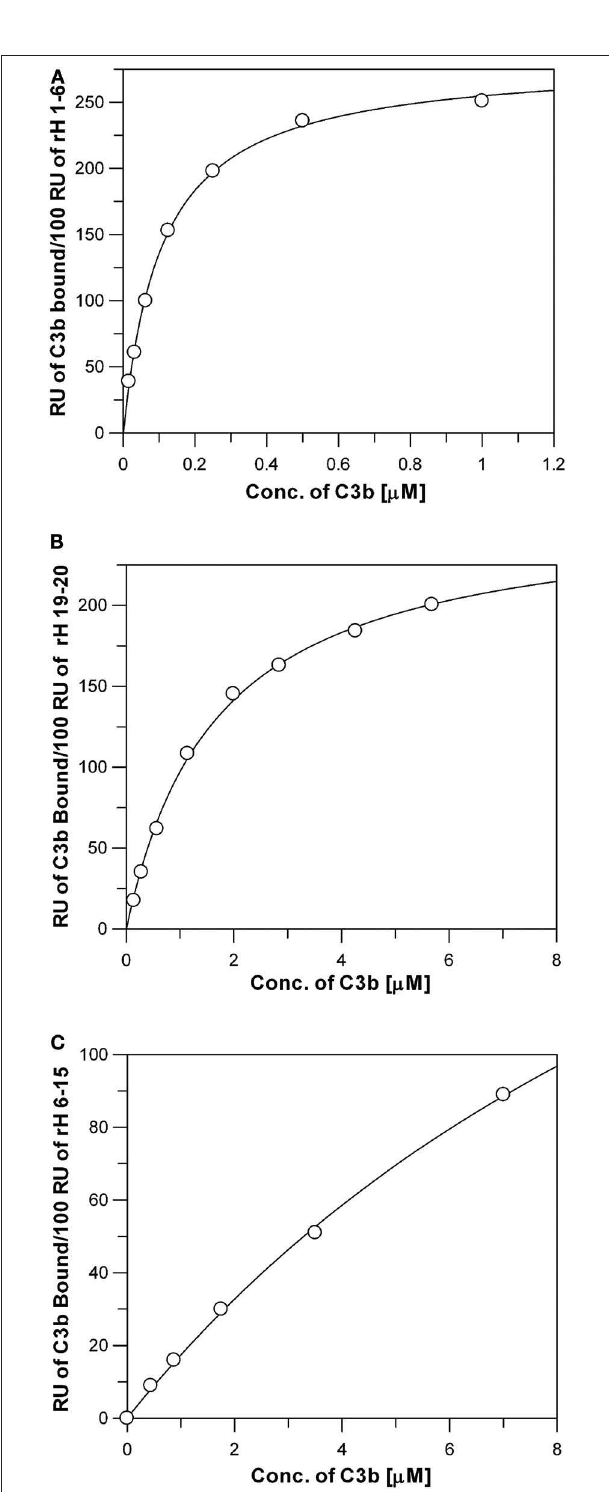
the measurement in this arrangement and both rH 1-6 and rH FIGURE 4 | Measurement of the affinity between C3b and the three C3b 1-20 exhibited a K d of ∼ 0.1 µ M. This assumes that Factor binding sites of Factor H. Each data point represents the equilibrium saturation level from one individual ligand binding curve from experiments like those described in Figure 3 . (A) rH 1-6 bound to the Ni-NTA chip exhibited the highest affinity and required C3b concentrations from 0.014 to 0.88 µ M to (Continued)